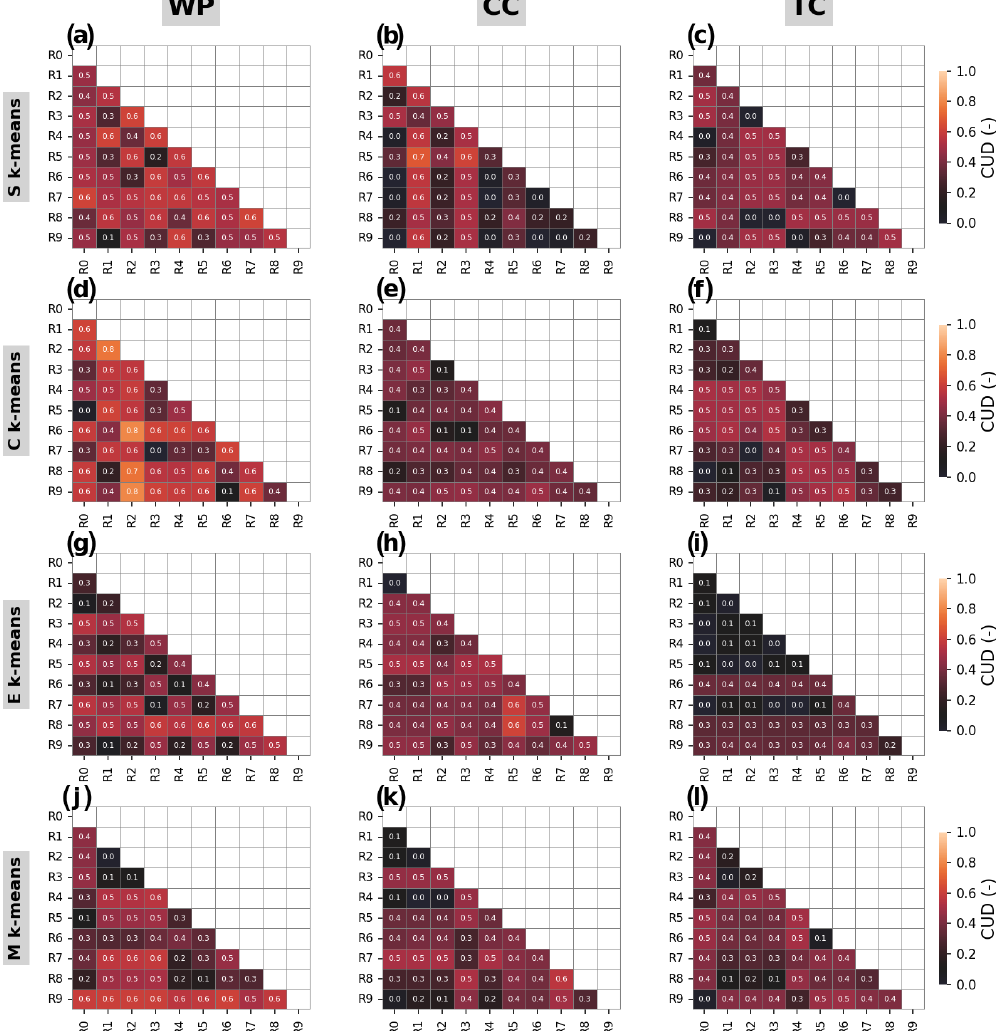
Figure 11. Clustering uncertainty degree (CUD) based on adjusted mutual information (AMI) between the clustering results from different runs (10 runs indicated by R0, R1, ..., R9) of different k -means algorithms, i.e., S, C, E, and M k -means (rows), for different demo experiments: WP, CC, and TC (columns). Note that the results are from the configuration with k = 4 and the first initialization